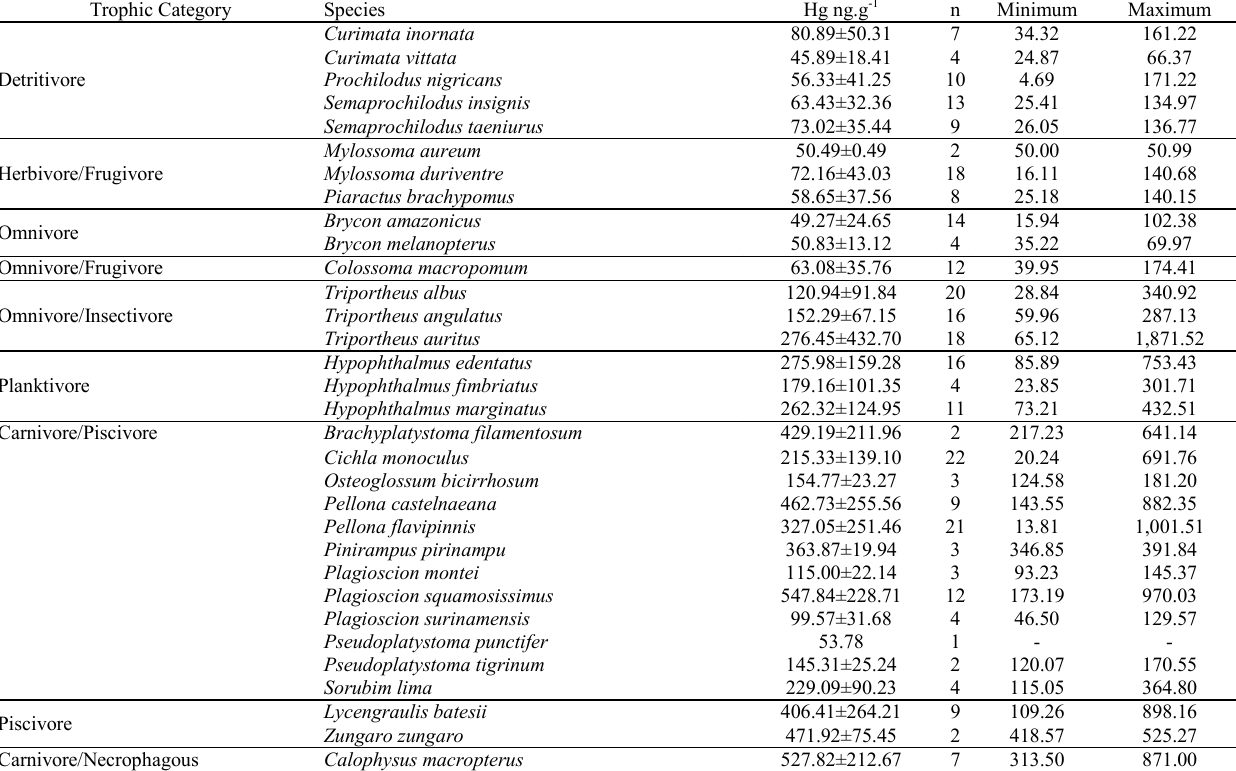
Table 1. Species organized in ascending order according to the mean concentration ± standard deviation of total mercury (Hg) within each trophic category in the muscle of fish of commercial importance from Lago Grande Manacapuru. n: number of samples